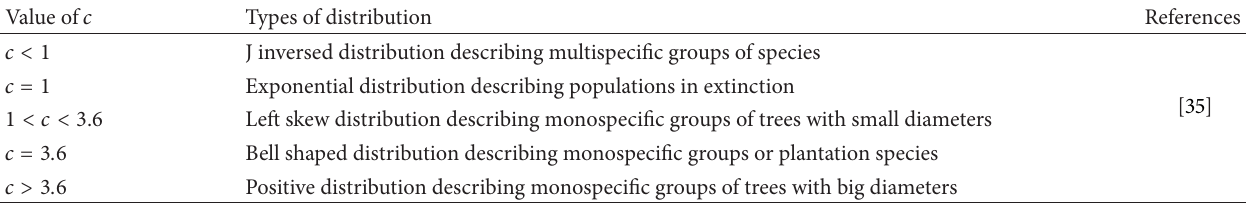
Table 3: Distribution forms from 3-parameter Weibull model according to the parameter 𝑐 .